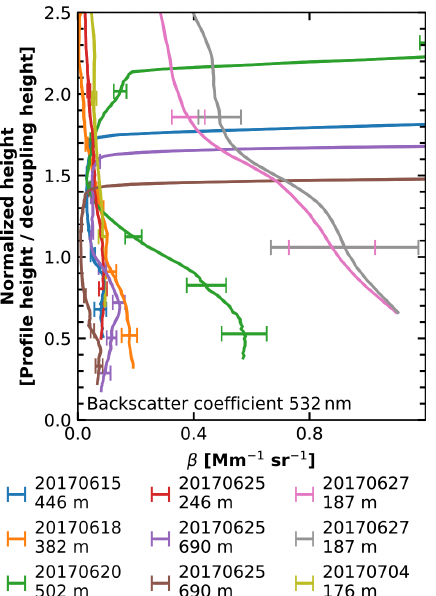
Figure 7. (a) Profiles of particle backscatter coefficient at 532nm from Polly XT . The date of the corresponding profiles together with the respective decoupling height is annotated below.